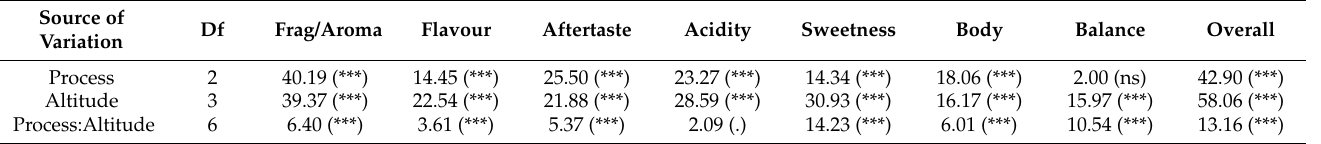
Table 2. Summary of F-values from analysis of variance (ANOVA) for congolensis according to sensory attributes.